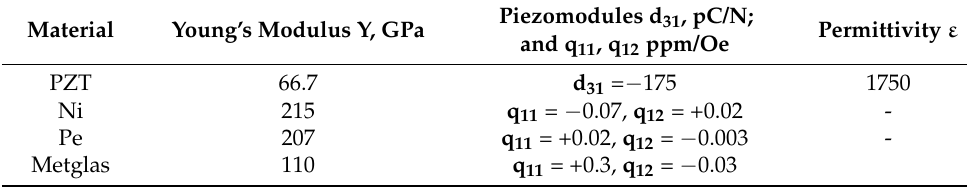
Table 1. Parameters of materials of composite